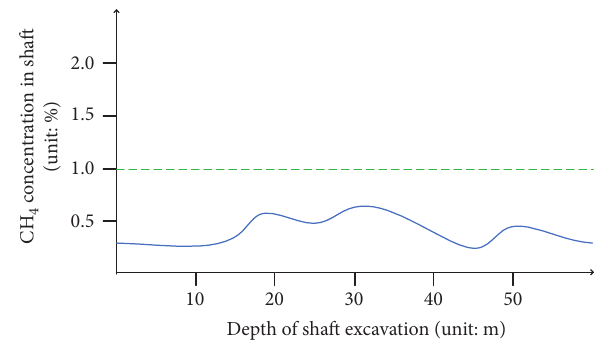
Figure 11: The curves of shaft sinking speed and methane